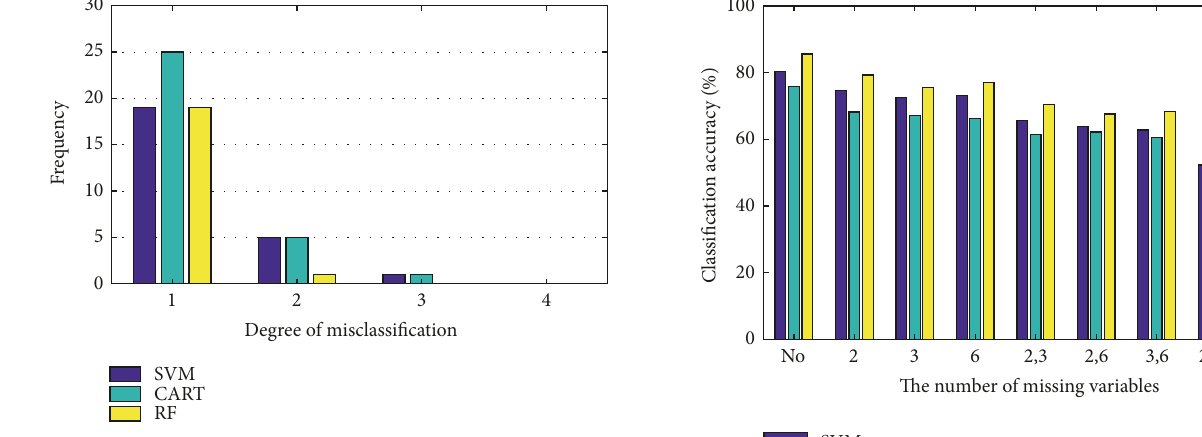
Figure 7: The frequency distribution of the misclassification degree of these three methods.